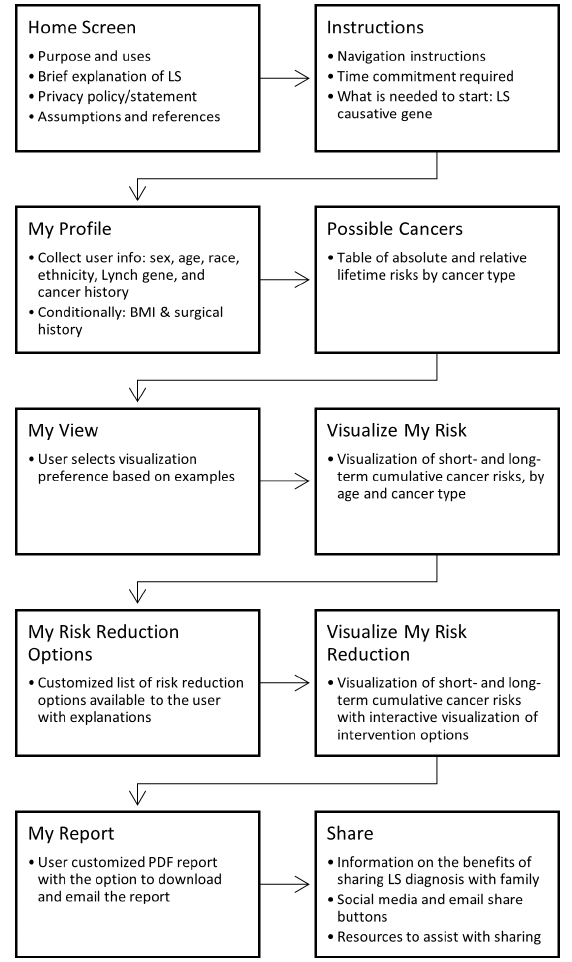
Figure 1. Flowchart of steps a user takes to navigate